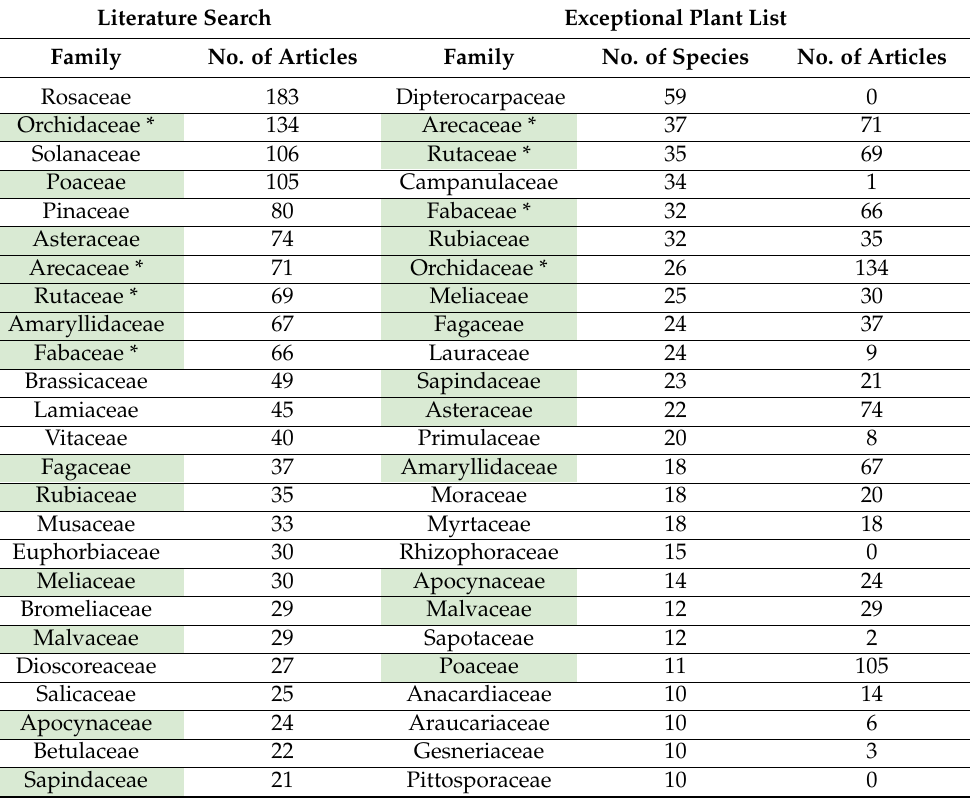
Table 1. The top 25 families with the most Web of Science articles identified, compared with the 25 families on the Working List of Exceptional Plants with the largest number of species currently known to be exceptional. Literature Search Family No. of Articles Rosaceae